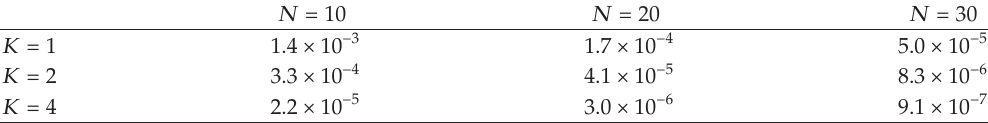
Table 8: Maximum absolute errors for a (cid:8) b (cid:8) c (cid:8) e (cid:8) 1 ,α 1 (cid:8) 0 . 555 ,α 2 (cid:8) 1 . 455 for Example 3.6.